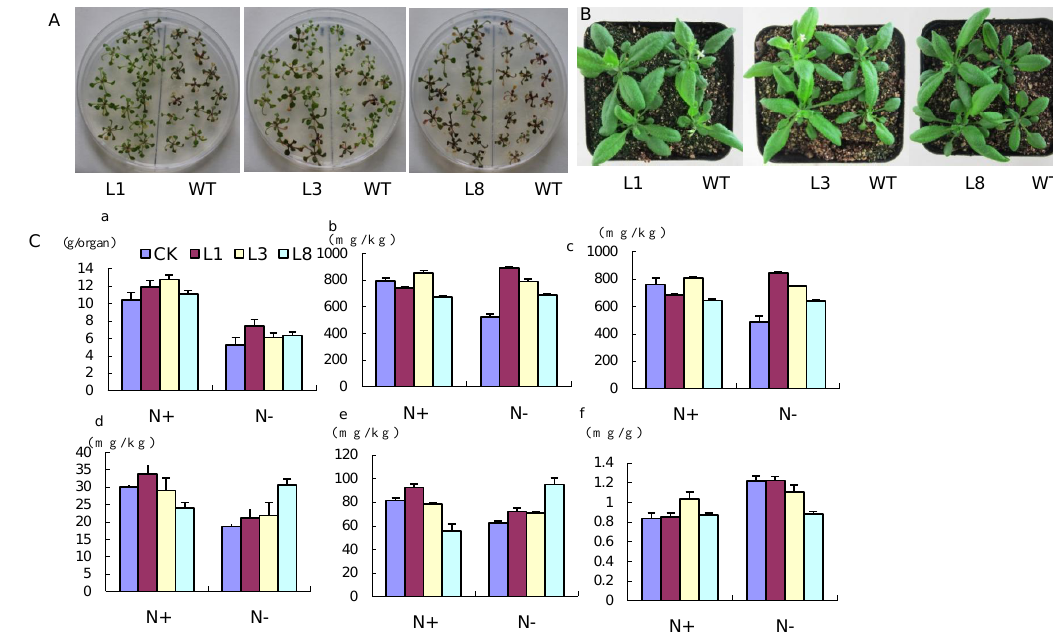
Figure 6. Enhanced low nitrogen stress tolerance in plants overexpressing GmCBS21 . ( A ) The phenotype of transgenic plants and wild-type plants grown in low nitrogen medium. L1, L3 and L8 were transgenic lines. WT was wild-type control line; ( B ) The phenotype of transgenic plants and wild-type plants grown in low nitrogen vermiculite; ( C ) Several physiological indexes of transgenic plants and wild-type plants grown in low N and normal N condition. L1, L3 and L8 were transgenic lines. CK was wild-type control line. ( a ) Fresh weight of wild-type and GmCBS21 plants; ( b ) Total nitrogen concentration of wild-type and GmCBS21 plants; ( c ) Nitrate-N concentration of wild-type and GmCBS21 plants; ( d ) Ammonium nitrogen concentration of wild-type and GmCBS21 plants; ( e ) Non-protein nitrogen concentration of wild-type and GmCBS21 plants; ( f ) Soluble sugar contents of wild-type and GmCBS21 plants. L1, L3 and L8 were transgenic lines. WT was wild-type control line. Arabidopsis thaliana seedlings were treated with normal nitrogen (N+) and low nitrogen (N ´ ). Seven-day-old plants grown on 1/2 MS medium were transferred to vermiculite supplied with 1/2 Hoagland’s solution and left to bolt (two weeks). Then, they were transferred to normal 1/2 Hoagland’s solution and low nitrogen 1/2 Hoagland’s solution, respectively. After nine days in the low nitrogen solution, all plants were harvested. Data represent as the mean value ˘ S.E. of three